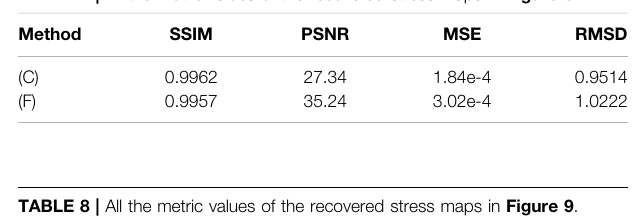
TABLE 7 | All the metric values of the recovered stress maps in Figure 8 .